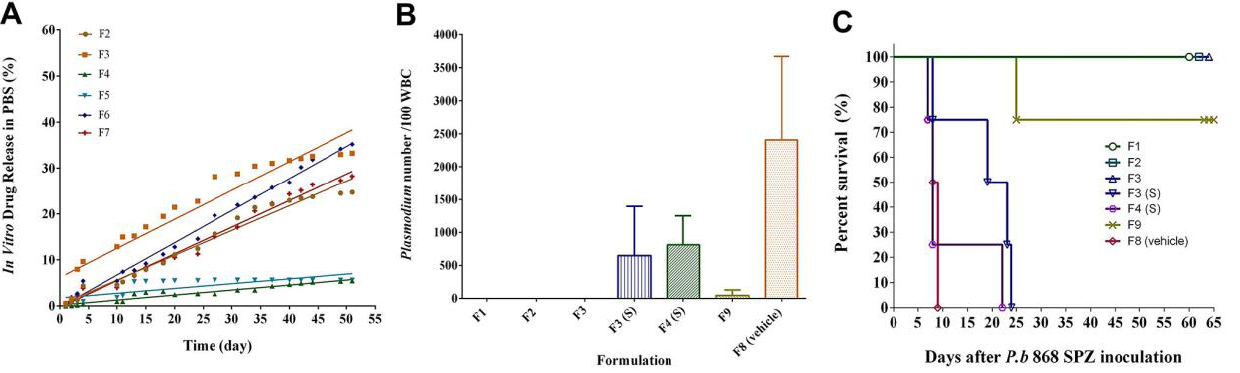
Figure 1. In vitro dissolution and in vivo efficacy assessment of sustained-release formulation of decoquinate (SRFD). ( A ) In vitro release of DQ from the solid form of SRFD. Each data point represents the percentage of cumulative drug released from the solid formulation of DQ, the drug released and accumulated from all previous times. ( B ) Microscopic examination of parasitemia in mice. The examination was carried out 4 days after the mice were infected by the Plasmodium berghei sporozoites. Lipids-based formulation of DQ was placed 34 days before Plasmodium infection. F1, F2, F3, and F8 were each suspended in saline and given to mice intramuscularly (IM). F4 was injected in solid form (stick) subcutaneously; F3 was also given in solid stick. F9 was prepared and injected as an emulsion. ( C ) Survival rates. The mice from the experiments shown in ( B ) were raised for 60 days and survival rates were counted 60 days